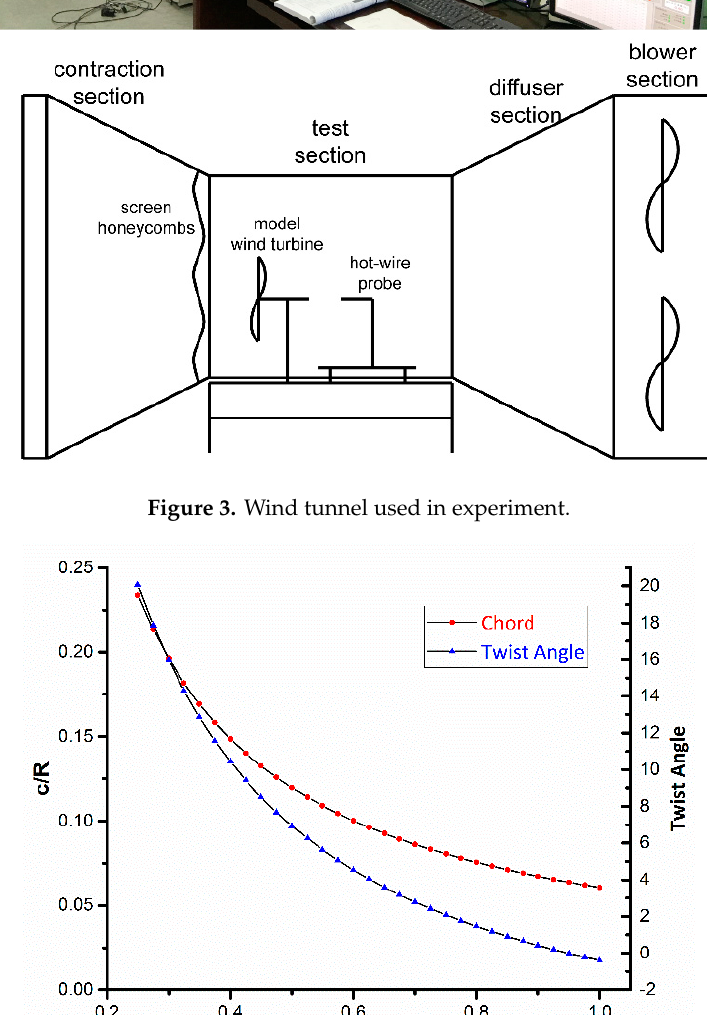
Figure 4. Length and twist angle distribution of the aerodynamics significant part of the blade.